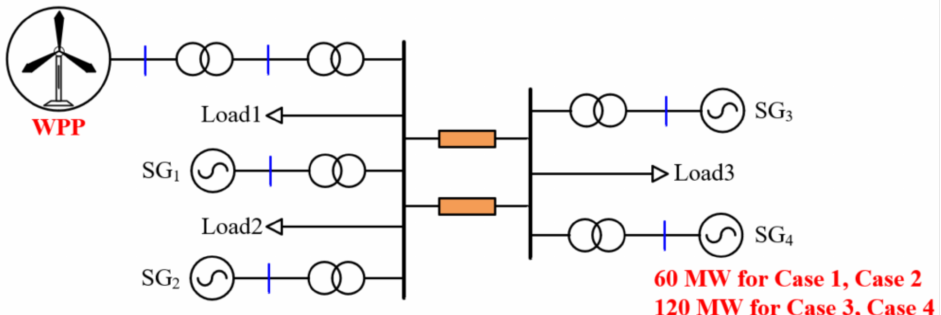
Figure 4. Model system embedded with a DFIG-based